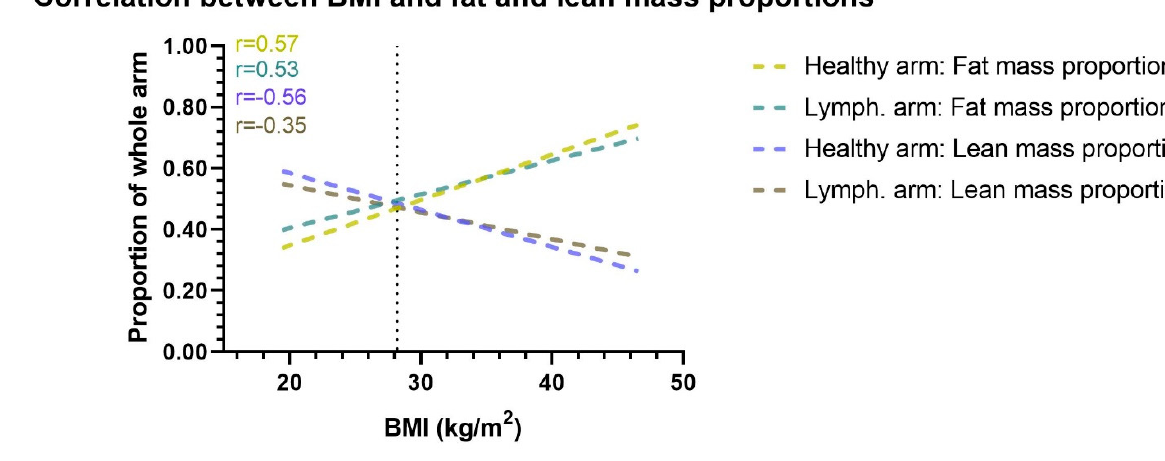
Figure 4. Correlation between BMI and arm proportion of fat and lean mass. This figure shows the correlation between BMI and the proportional amount of lean and fat mass in the healthy and lymphedema arm. Correlation lines are shown as lines of best fit through a scatterplot. When BMI increases the lymphedema and healthy arms proportion of fat mass increases, while the proportion of lean mass decreases. The vertical dotted line denotes the mean BMI of the cohort. Lymph. = lymphedema. r= Pearson r correlation.